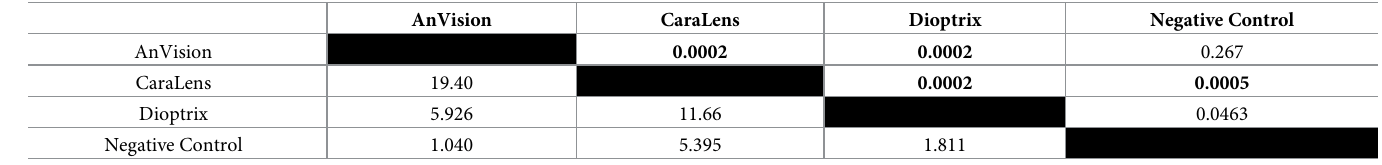
Table 2. Pairwise comparisons by brand using Bray Curtis similarities.